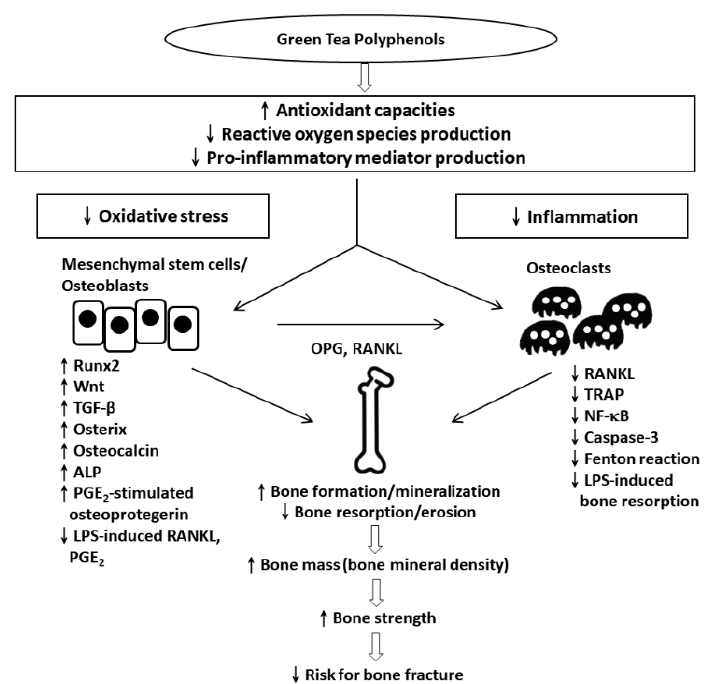
Figure 1. Summarized mechanisms of green tea polyphenols (GTP) in bone protection. Green tea catechins increase antioxidant capacities, reduce oxidative stress, and suppress the production of pro-inflammatory mediators. In osteoblasts, GTP inhibits oxidative stress by the upregulation of Runx2, Wnt, TGF- β , Osterix, Osteocalcin, and ALP. Moreover, RANKL, TRAP, and NF- κ B activities are downregulated and caspase- 3 and Fenton reaction activities are upregulated in osteoclasts by GTP treatment. These actions should contribute to enhance bone formation/mineralization, and reduce bone resorption/erosion, resulting in increased bone mass, bone mineral density, and bone strength, leading to a reduced risk of bone fracture. ALP, alkaline phosphatase; GPX, glutathione peroxidase; NF- κ B, nuclear transcription factor- κ B; PGE2, prostaglandin E2; RANKL, receptor activator of nuclear transcription factor- κ B ligand; Runx2, Runt-related transcription factor 2; SOD, superoxide dismutase; TGF- β , transforming growth factor β ; TRAP, tartrate-resistant acid phosphatase; ↑ , upregulated; ↓ , downregulated.